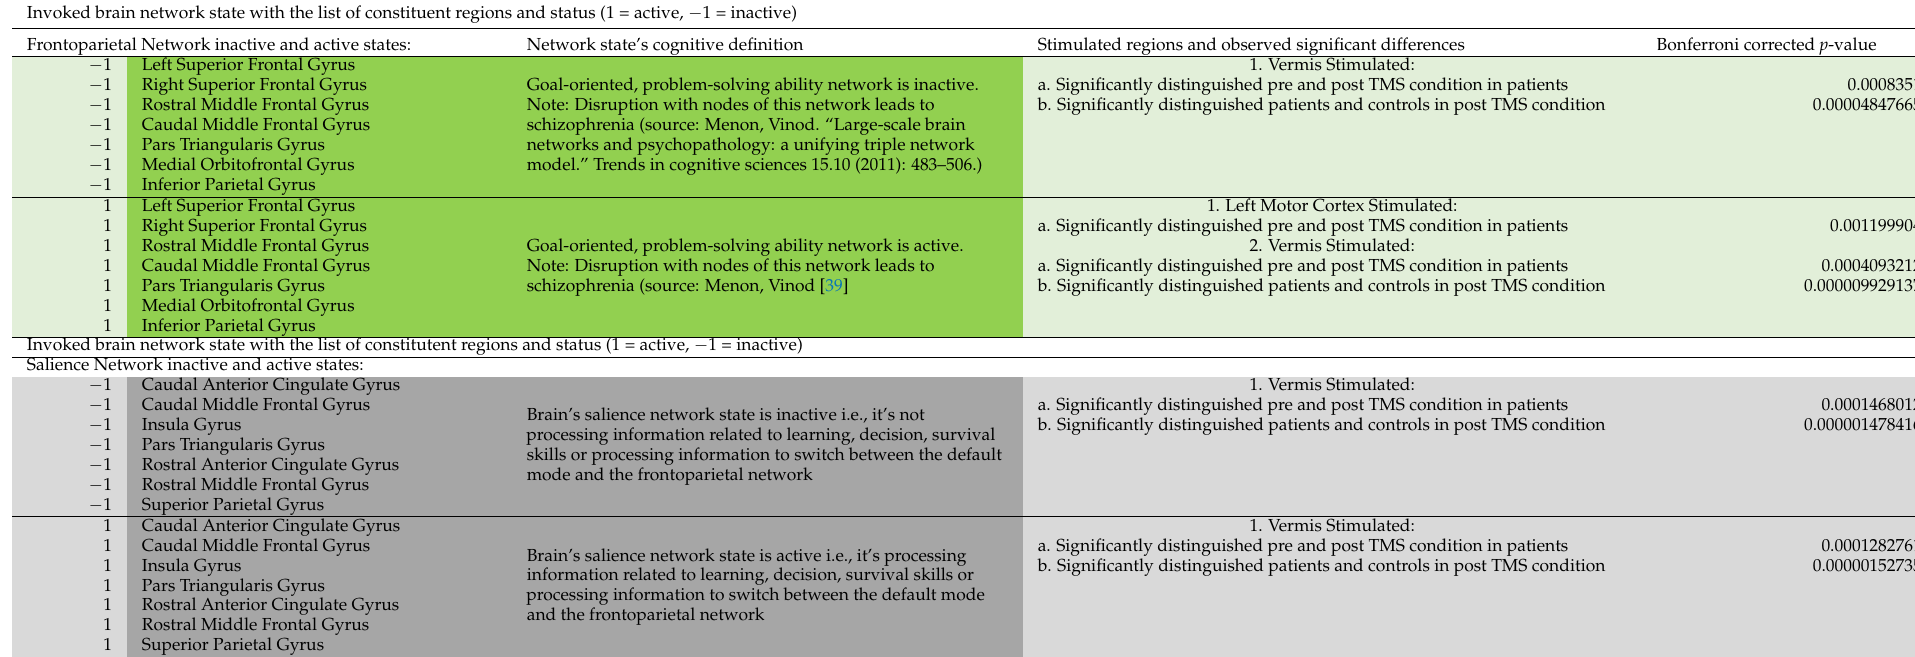
Table 4. Connectivity network state summary for the states of frontoparietal, salience, and attention network when the left motor, left prefrontal cortex, and vermis are stimulated by the TMS subthreshold